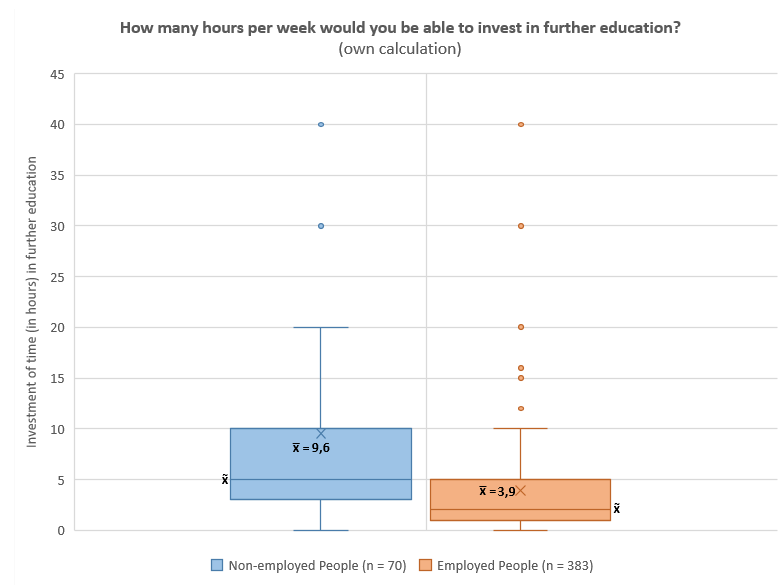
Figure 3: Boxplot of investment of time in further education by non-employed and employed people in the population survey t -test shows that there is a significant difference ( T = 4 . 483; p ( t ) : 0 . 000). The